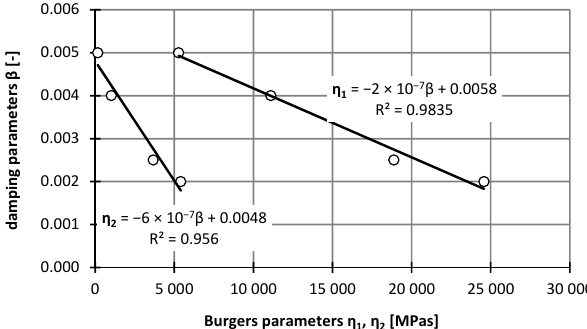
Figure 15. The relationship between the phase angle and the damping parameters (asphalt mixtures with an asphalt content of